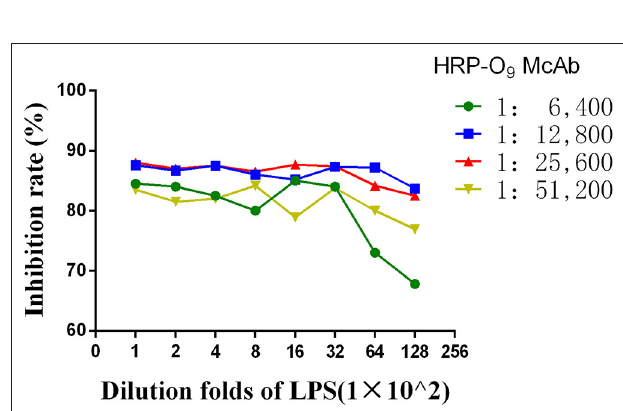
FIGURE 1 | Standard curve of sugar concentration determined by the anthracene-ketone method.